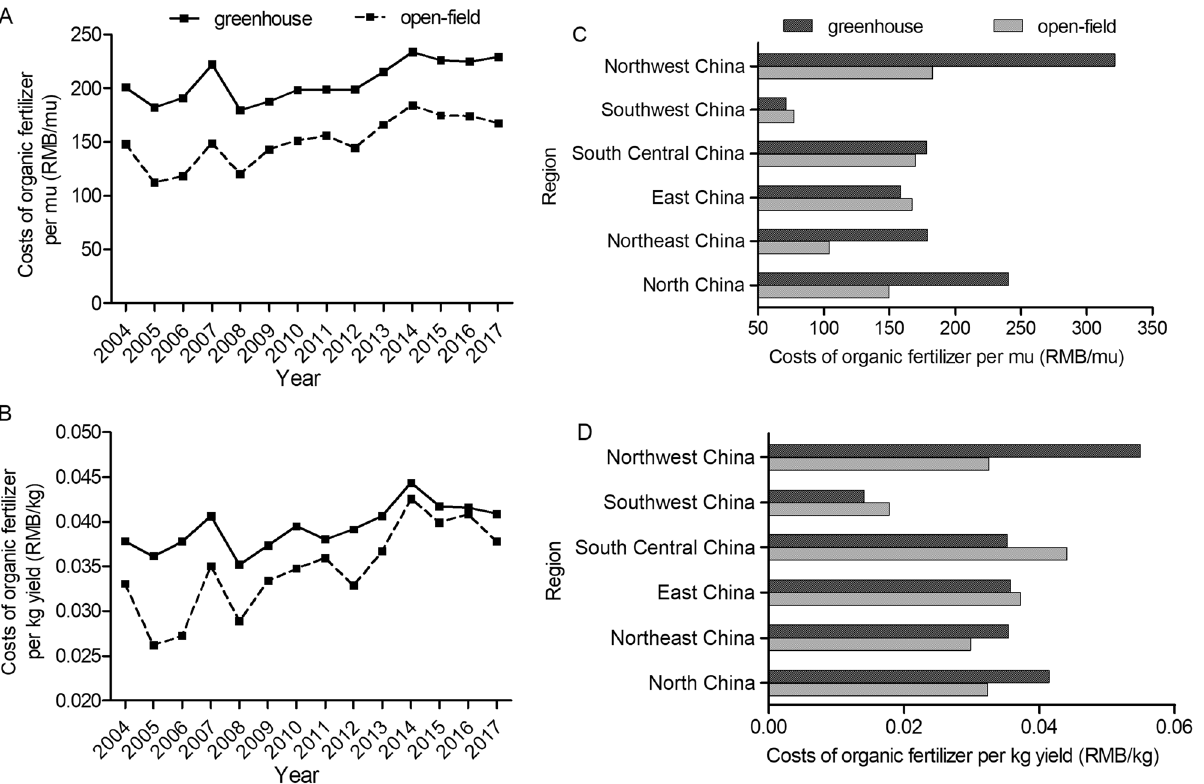
Figure 6. Pesticide costs for greenhouse and open-field tomatoes. ( A ) and ( B ) presented pesticide costs per mu and per kg yield during 2004–2017, respectively. ( C ) and ( D ) presented the average values of pesticide costs (per mu and per kg yield, respectively) across six regions in